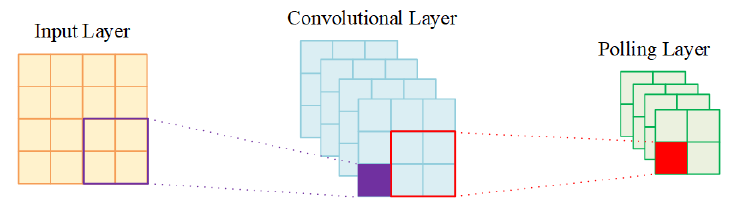
Figure 3. A complete convolution operation.